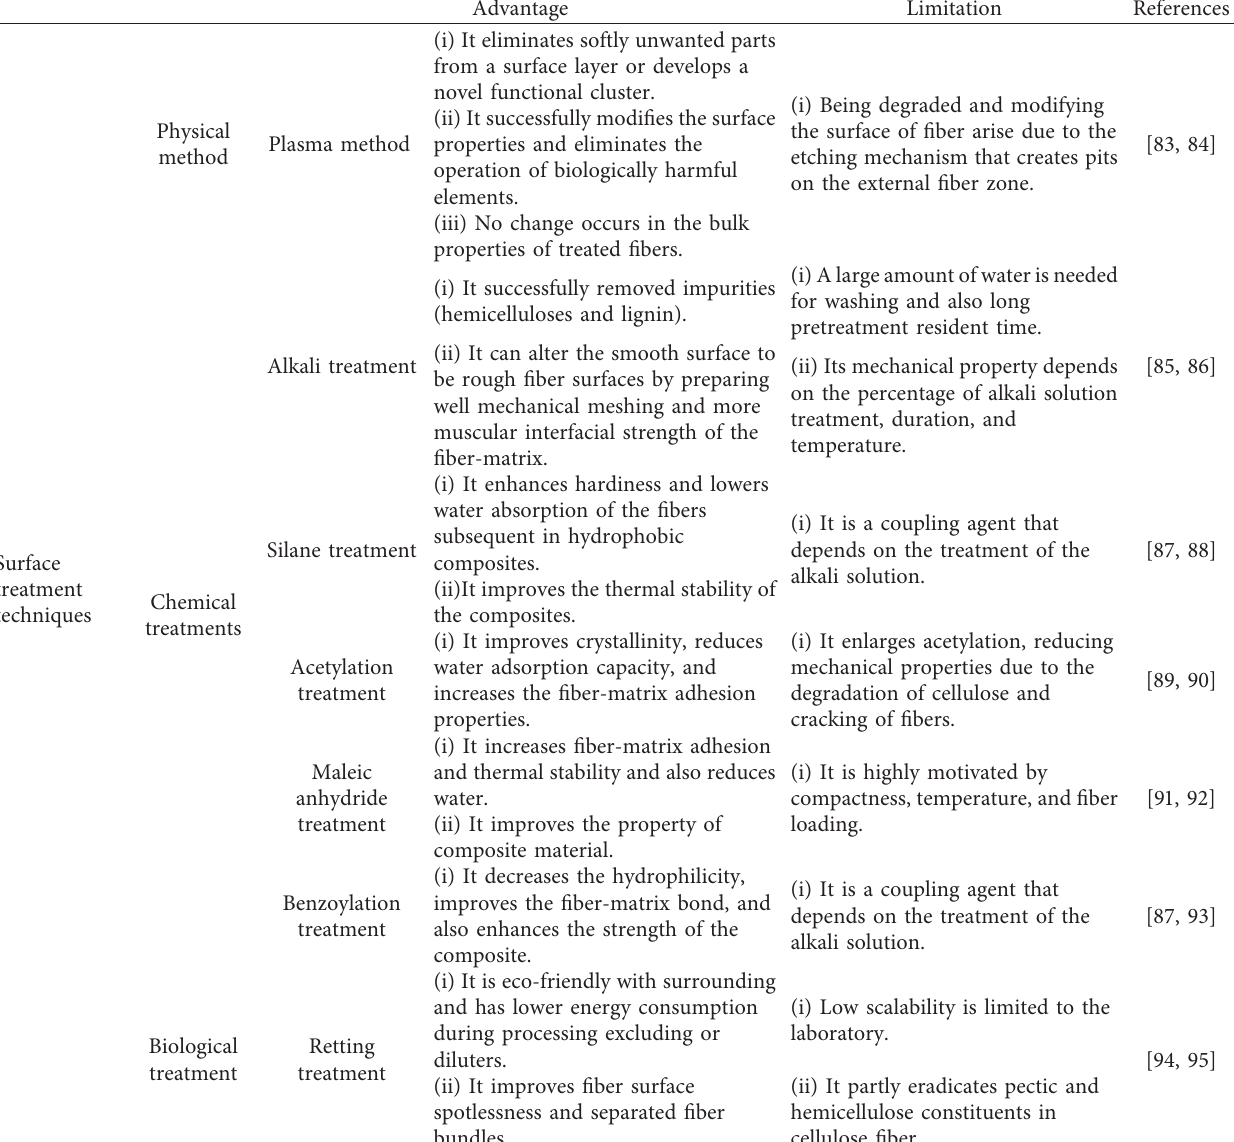
Table 4: Main advantage and limitation of each treatment technique.